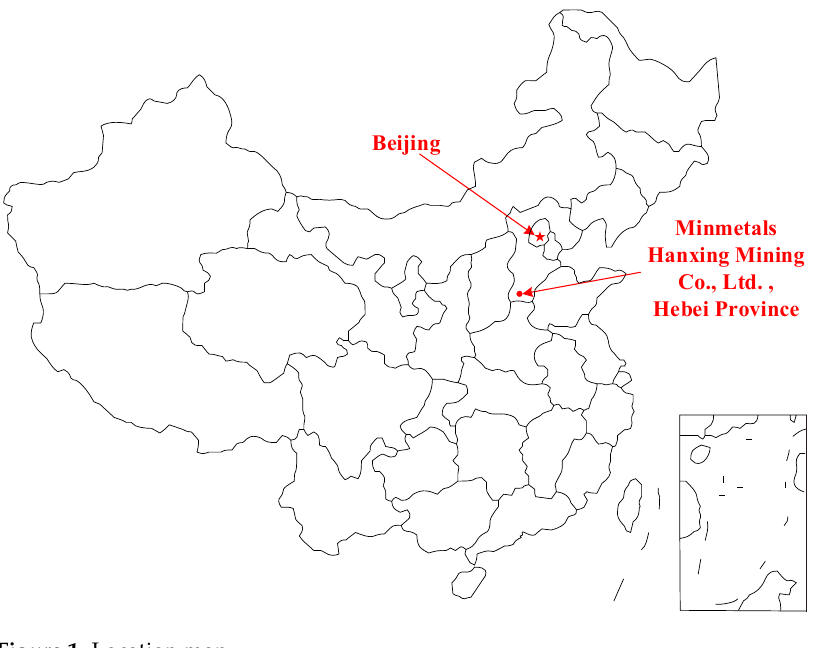
Figure 1. Location map.